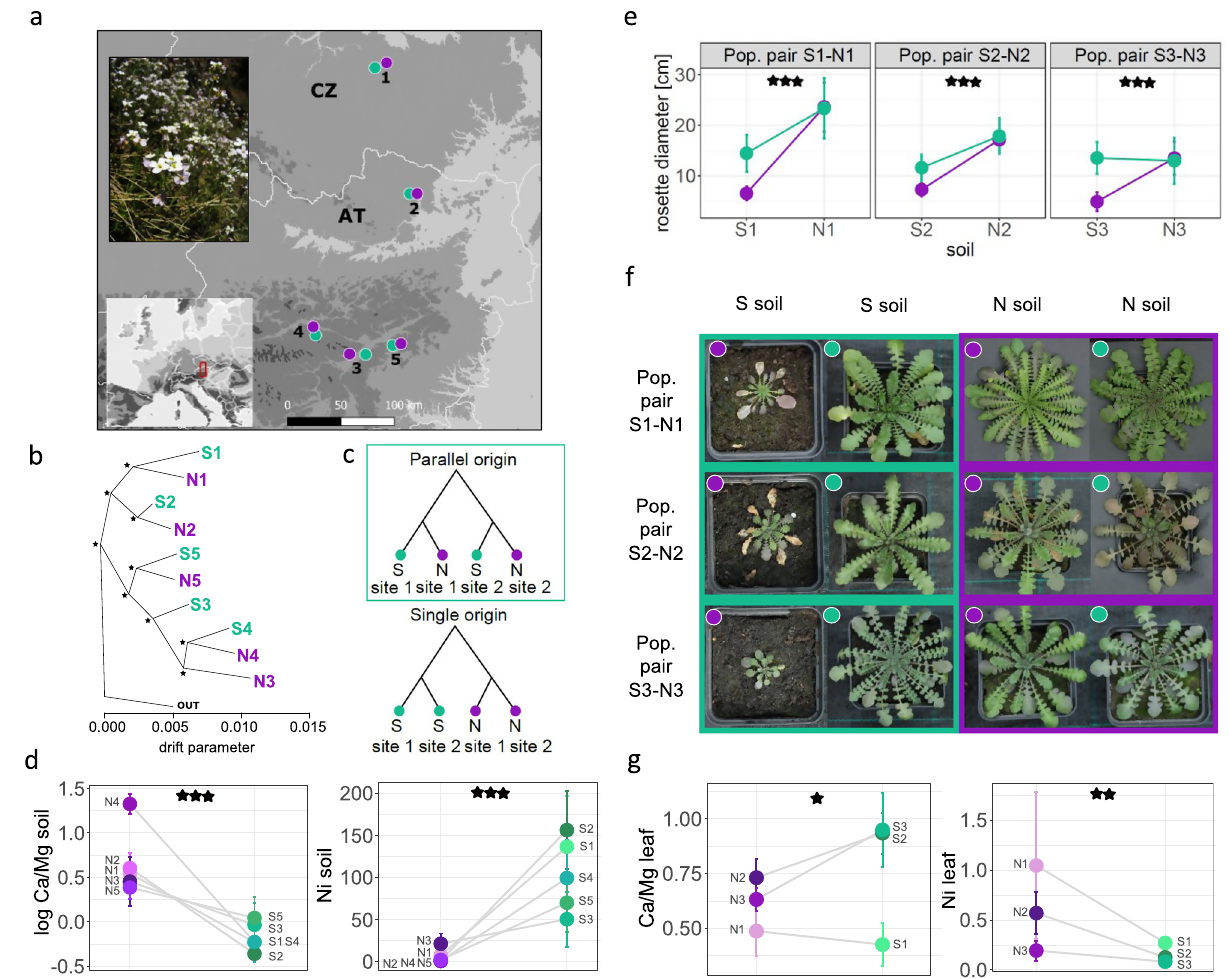
Fig. 1 Parallel adaptation of Arabidopsis arenosa to challenging serpentine soils. a Locations of the investigated serpentine (S, green) and non-serpentine (N, violet) populations sampled as spatially proximate pairs (numbers) in Central Europe with an illustrative photo of an S population (photo was taken by F. Kolá ř ). b Allele frequency covariance graph of populations based on ~870,000 fourfold-degenerate SNPs; asterisks show the 100 bootstrap branch support. The outgroup (OUT) is represented by a tetraploid population from Western Carpathians, the ancestral area of tetraploid A. arenosa 93 . c Two contrasting evolutionary scenarios of serpentine colonisation compared in coalescent simulations; the topology assuming independent serpentine colonisations (framed in green) received the highest support consistently across all 10 pairwise combinations of S – N population pairs. d Differences in Ca/ Mg ratio and in Ni concentrations [ µ g/g] in S and N soils from the original sampling sites ( n = 78 individual samples, one-way ANOVAs: F 1,77 = 26.5, p = 1.94e − 06 and F = 117.4, p = 2.01e − 16 for Ca/Mg and Ni, respectively). e Differences in maximum rosette size of three population pairs attained 1,77 after 3 months of cultivation in local serpentine and non-serpentine substrates (signi fi cance of the soil treatment × soil origin interaction in a two-way ANOVA is indicated: F 1,90 = 21.6, p = 1.17e − 05, F 1,96 = 12.3, p = 6.88e − 04, and F 1,85 = 42, p = 5.68e − 09 for population pairs 1, 2 and 3, respectively). f Example photos illustrating parallel growth response in the three population pairs to serpentine soils (green frame) depending on the soil of origin (dot colour) (photo was taken by V. Kone č ná). g Differences in ion uptake between originally S and N individuals when cultivated in serpentine soils; Ni concentrations were standardised by corresponding soil Ni values ( n = 28 individual samples, one-way ANOVAs: F 1,27 = 6.2, p = 0.019 and F 1,27 = 13.5, p = 0.001 for Ca/Mg ratio and Ni, respectively). Points denote mean, error bars depict standard error of mean in charts e , d , g . Source data underlying Fig. 1d, g are provided as a Source data fi